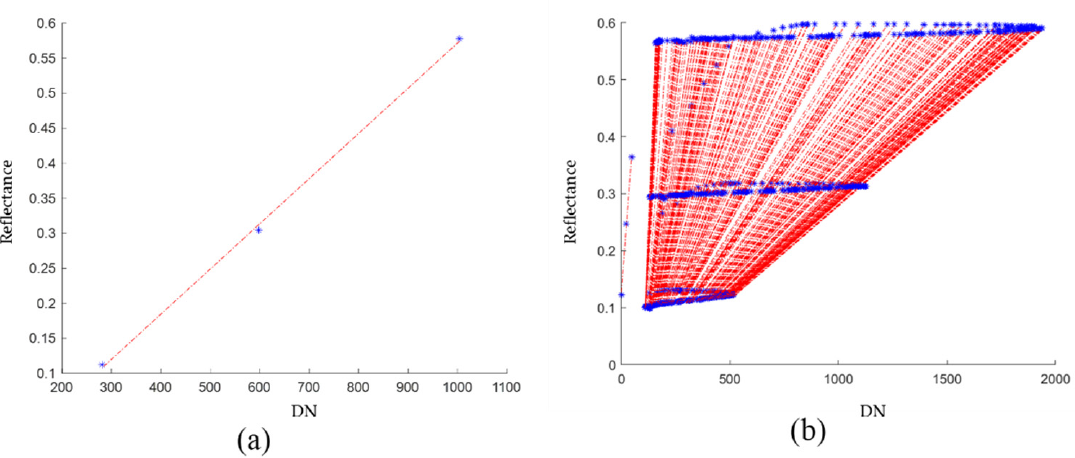
Figure 10. Emissivities versus wavelength: ( a ) linear regression for each pixel of different emissivi- ties at a specific wavelength. ( b ) Linear regression for each pixel of different emissivities for all the acquired wavelengths. The asterisks correspond to the emissivity percentage of the colors of the template for different wavelengths: Black (10%), Gray (30%) and White (57%). From MATLAB point of view, this correction consists in a multiplication of each pixel (in the matrix at each spectral band) with its corresponding correction values. A new cubic hyperspectral image is obtained by applying the correction to all the layers. Figure 11 shows the flowchart of the algorithm used to generate the corrected hyperspectral image.